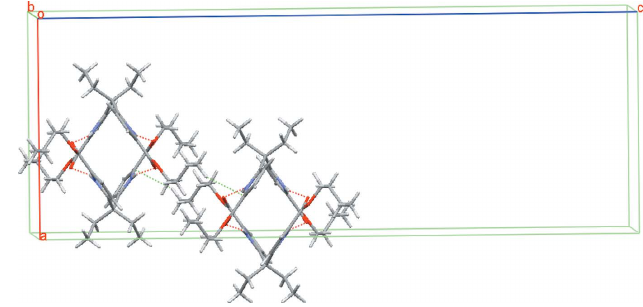
Figure 2 Part of the crystal packing showing molecules linked by N—H (cid:2)(cid:2)(cid:2) O